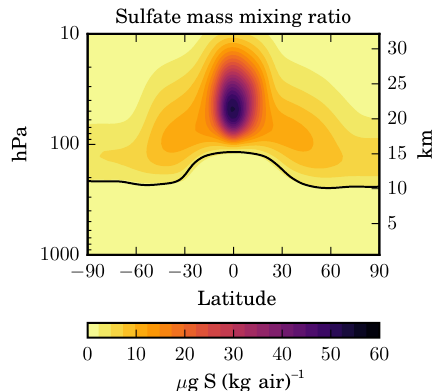
Figure 3. Latitude–height cross section of the zonal and annual mean temperature anomaly (in K) in the STANDARD experiment relative to the CONTROL